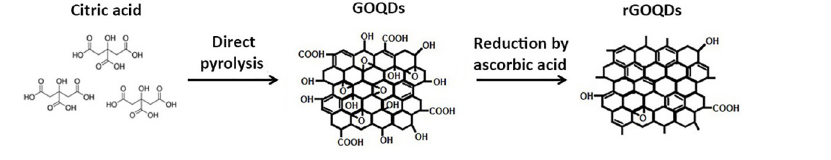
Fig 1. Schematic presentation of GOQDs synthesis and